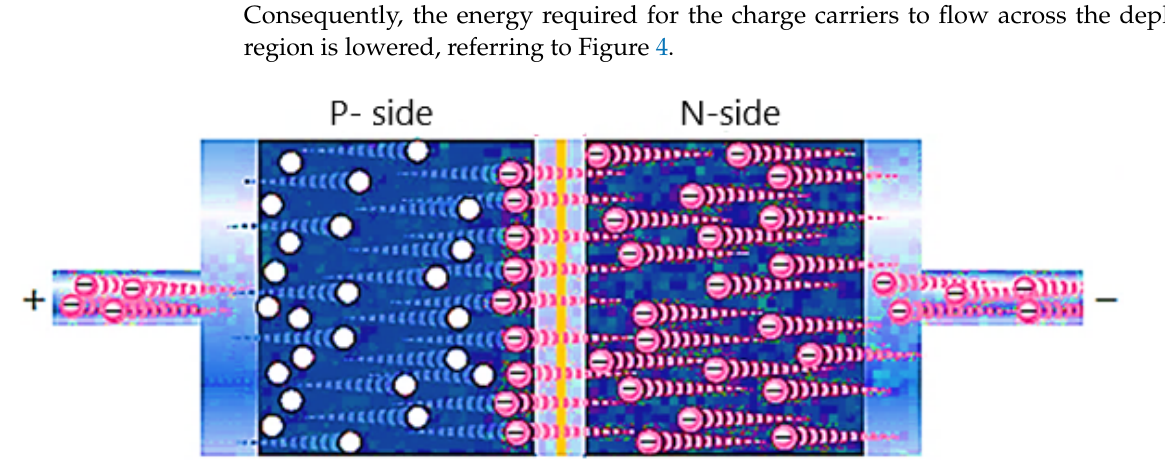
Figure 4. The flow of majority carriers in a forward-biased diode.